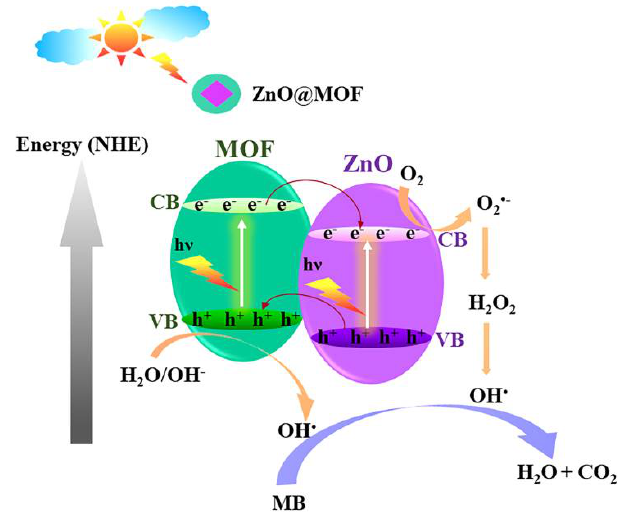
Figure 20. Photocatalytic mechanism of ZnO@MOF-46(Zn). Proposed reaction mechanism over ZnO@MOF-46(Zn) for photodegradation.